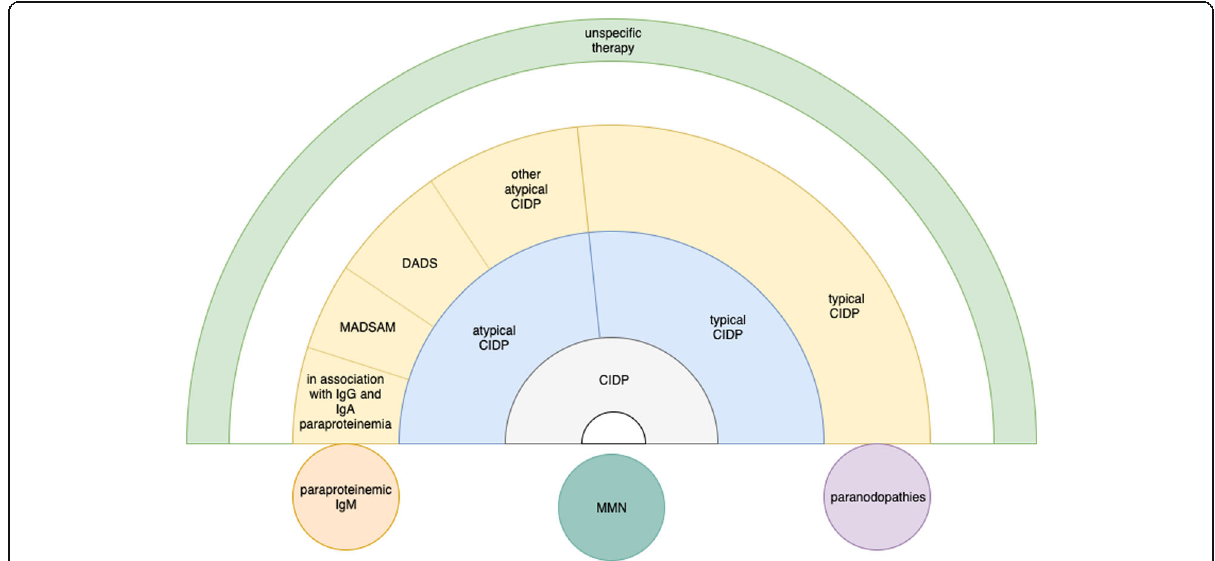
Fig. 1 Overview of inflammatory neuropathies with focus on CIDP, subtypes and distinct disease